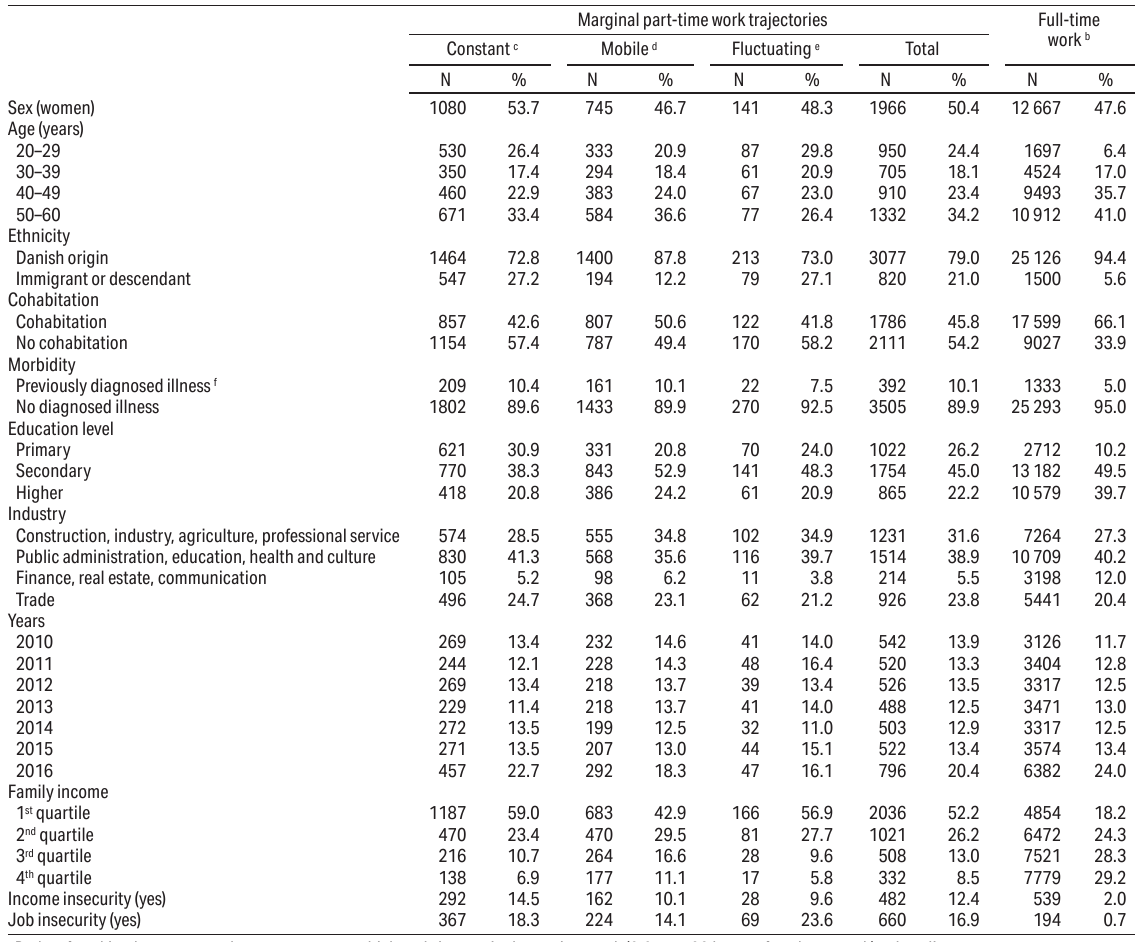
Table 1. Descriptive characteristics of the study population at baseline by the three retrospective trajectories a of marginal part-time work and full-time work (N = 30